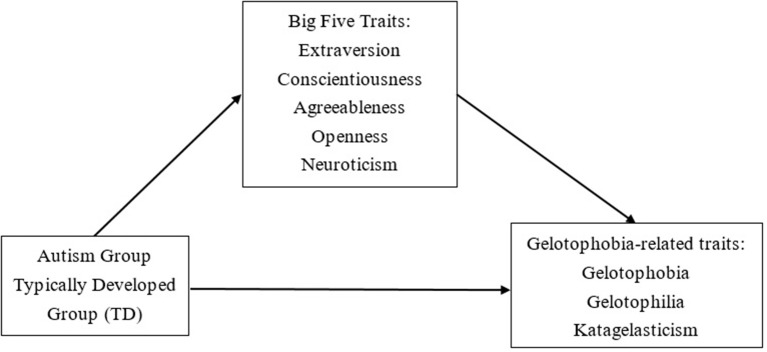
Research structure.